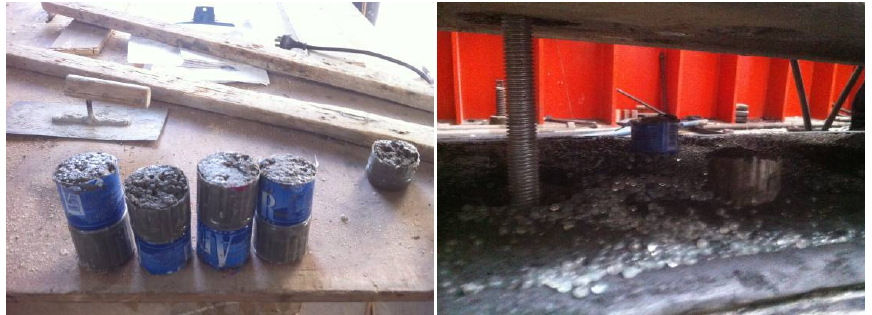
Figure 9. Mortar bar(s).